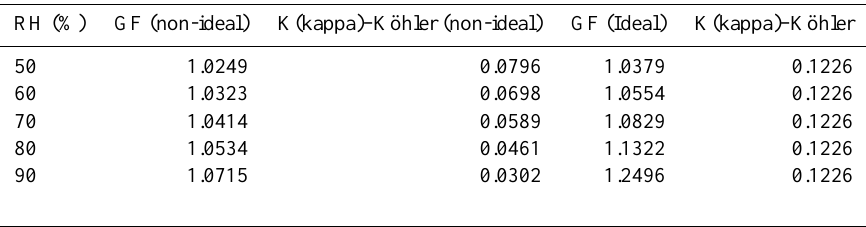
Table 5. Variable growth factor, with and without solution non-ideality, between 50 and 90%RH, of a mixed aerosol comprised of (NH 4 ) 2 SO 4 and the 90 organic compounds, assuming an equimolar mixture, presented by O’meara et al. (2014) for their vapour pressure predictive technique evaluation study.